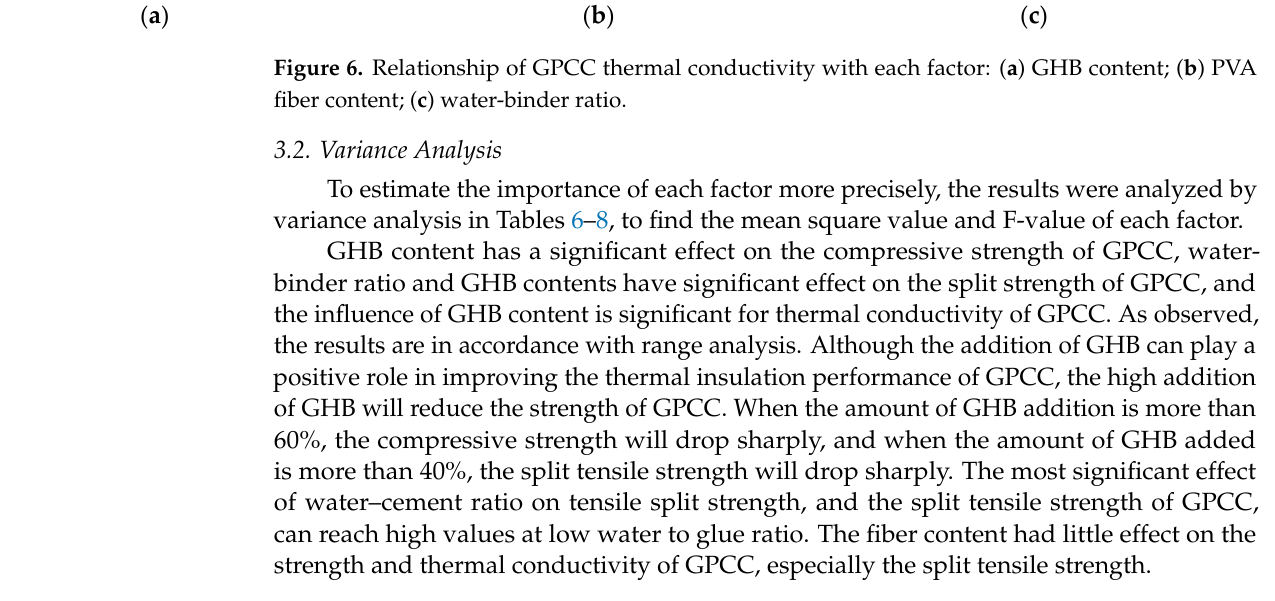
Table 6. Variance analysis results of compressive strength.